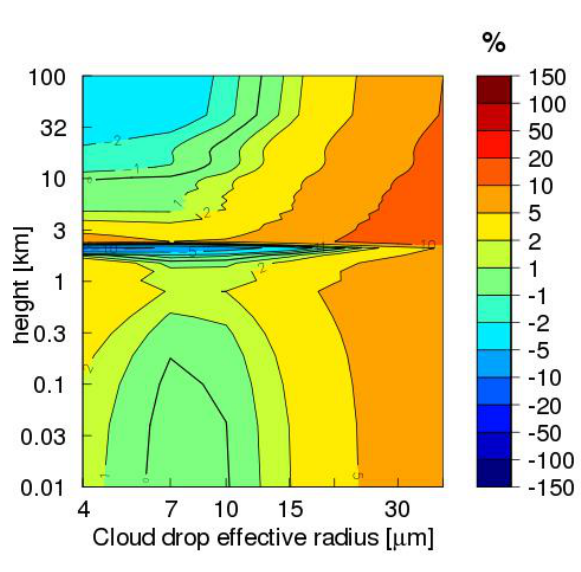
Figure 16. As for Fig. 11 but for varying r e , liq (experiment 5). Relative differences in net fluxes between IFS-Fouquart and HS- DISORT.